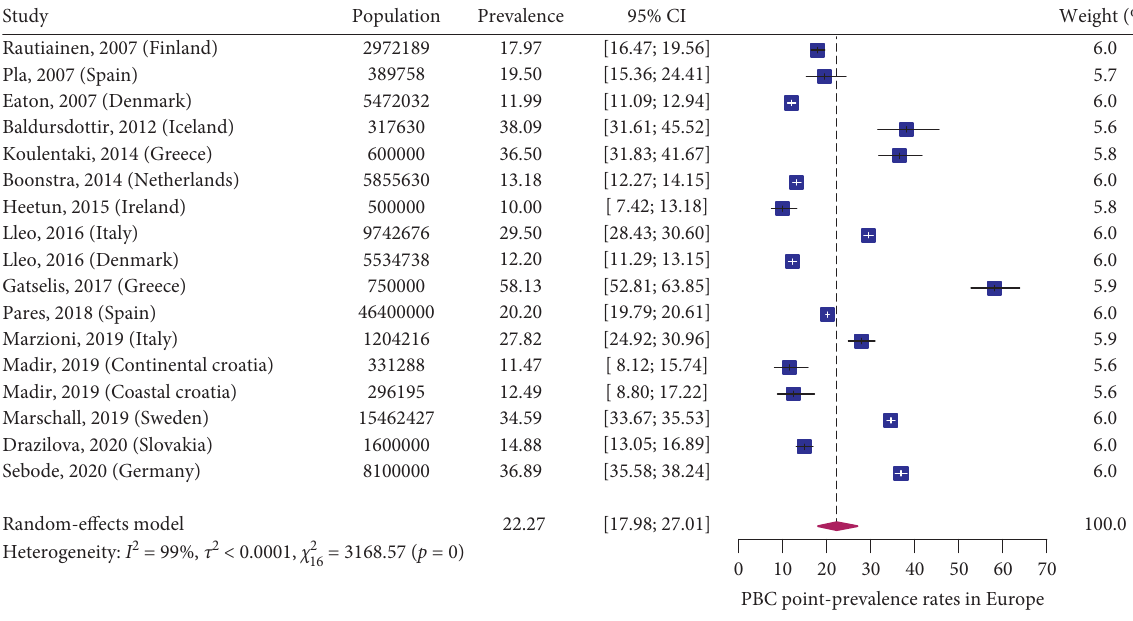
Figure 3: PBC point-prevalence rates in